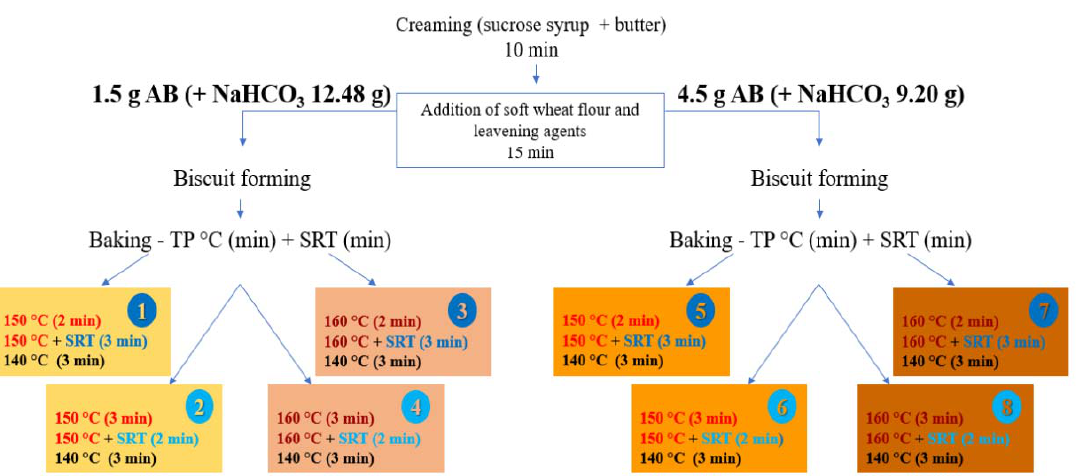
Figure 1. Diagram of the whole process and of the sample set obtained through the FDOE. AB, ammonium bicarbonate; TP, baking temperature program; SRT, steam release time.